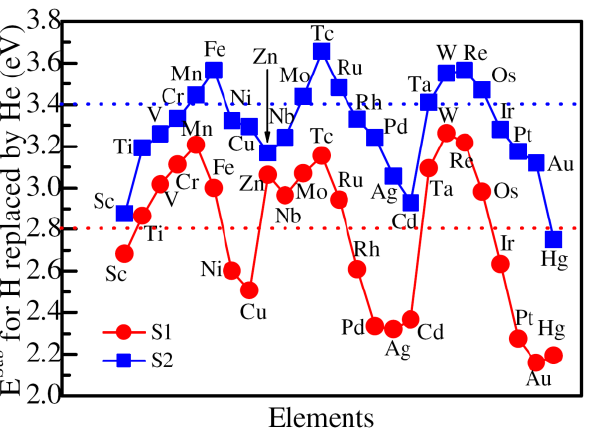
Figure 4. The substitution energy of He replacing H at the closest site of the Co atom, which is substituted by various alloying elements. S1 and S2 suggest the closest and next closest sites to Co substituted by 3 d , 4 d , and 5 d alloying elements.